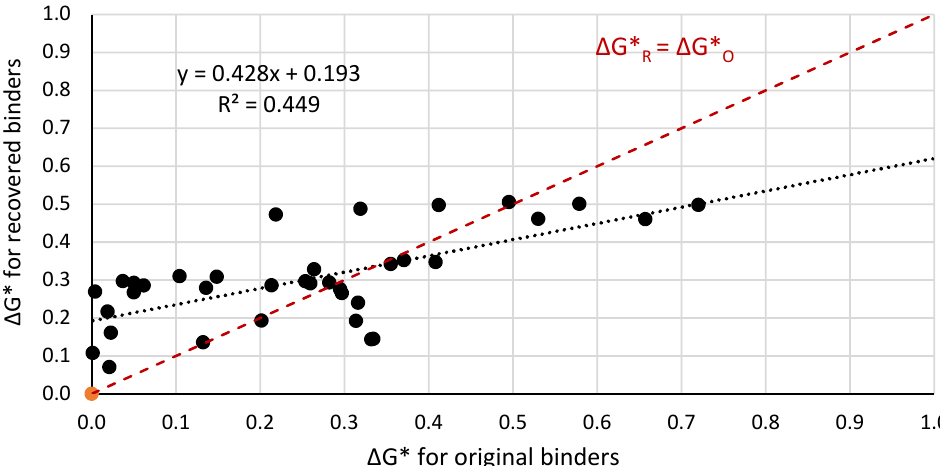
Figure 7. Correlation of the ∆ G* R index for extracted binders and ∆ G* O index for original binders in the temperature range from − 5 °C to +100 °C limited only to the group of polymer-modified bitumens.